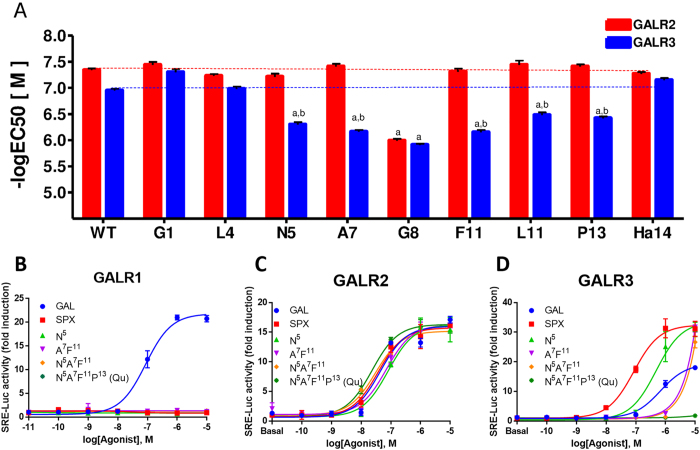
Differential effects of GAL-specific residue substitution in SPX on potencies toward GALR1, GALR2, and GALR3.The SRE-luc reporter vector and plasmid containing human GALR1, GALR2, or GALR3 were transfected into HEK293 cells that stably expressed Gqi protein. Cells were then treated with increasing concentrations of mutant peptides, and the receptor activities were determined using the SRE-luc reporter system. (A) Potencies of mutant peptides toward GALR2 (red bars) and GALR3 (blue bars) are expressed as −log[EC50] values. The horizontal dashed lines represent potency of WT SPX toward receptors. (B–D) Dose-response activity fold induction by peptides with multiple substitutions on GALR1 (B), GALR2 (C), and GALR3 (D).WT SPX and GAL were used as control peptides. a, P < 0.05 vs. WT SPX; b, P < 0.05 vs. activity with GALR2.